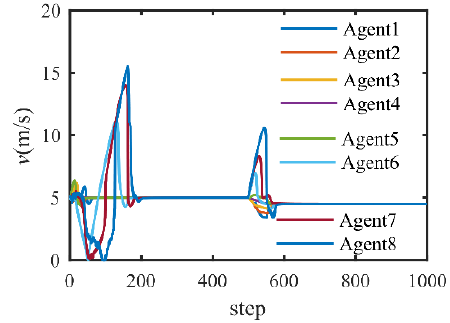
Figure 4. Velocity control result with linear controller.